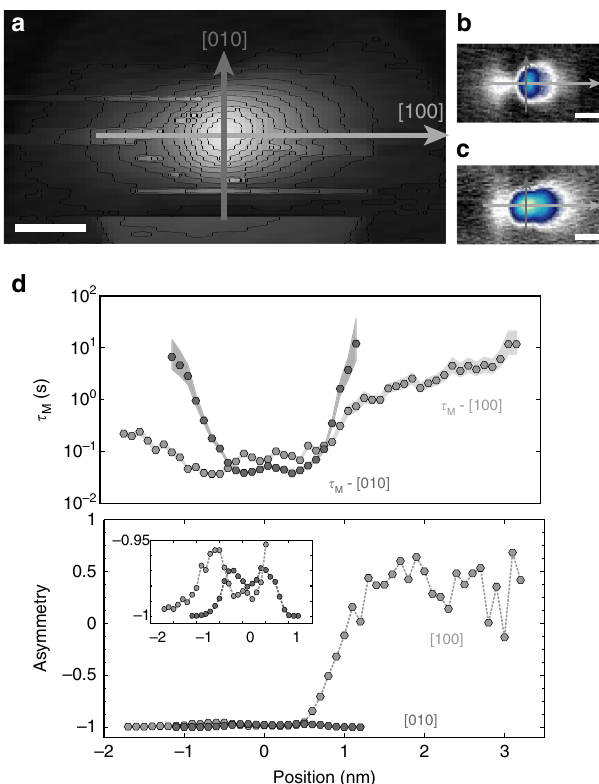
Fig. 5 Anisotropic gating. a Constant-height current map showing Co charge density at V s = 500 mV (setpoint conditions: V s = 500 mV, I = 40 pA, scale bar = 1 nm). Dark gray and light gray arrows show t measurement positions for d along [010] and [100], respectively. b Measurement locations shown on constant-current image of J V = − 400 mV, I = 20 pA, scale bar = 1 nm). c Measurement H,low ( s t locations with reference to J H,high ( V s = − 400mV, I t = 20 pA, scale bar = 1 nm). d Spatially resolved constant height measurements (setpoint conditions: V s = 500 mV, I t = 40 pA). Mean lifetime (top) and state asymmetry (bottom) as a function of position along (light gray) [100] and (dark gray) [010] directions. (Inset, bottom panel) Rescaled plot of asymmetry data from positions − 2 to 1 nm. The constant height image in a was taken with precisely the same tip height and bias to show the length scale of the ionized atomic wavefunction (atom is primarily in J H,low ). Position 0 nm corresponds to the center of the Co atom. Data